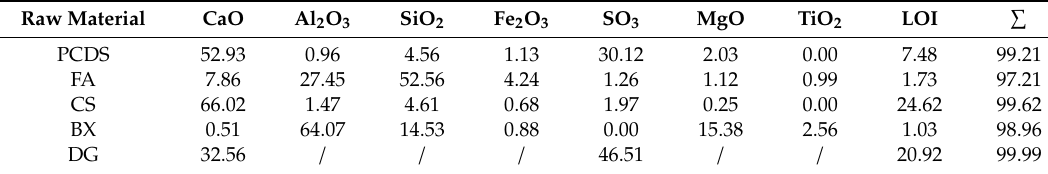
Table 1. Chemical composition of the raw materials, wt.%.